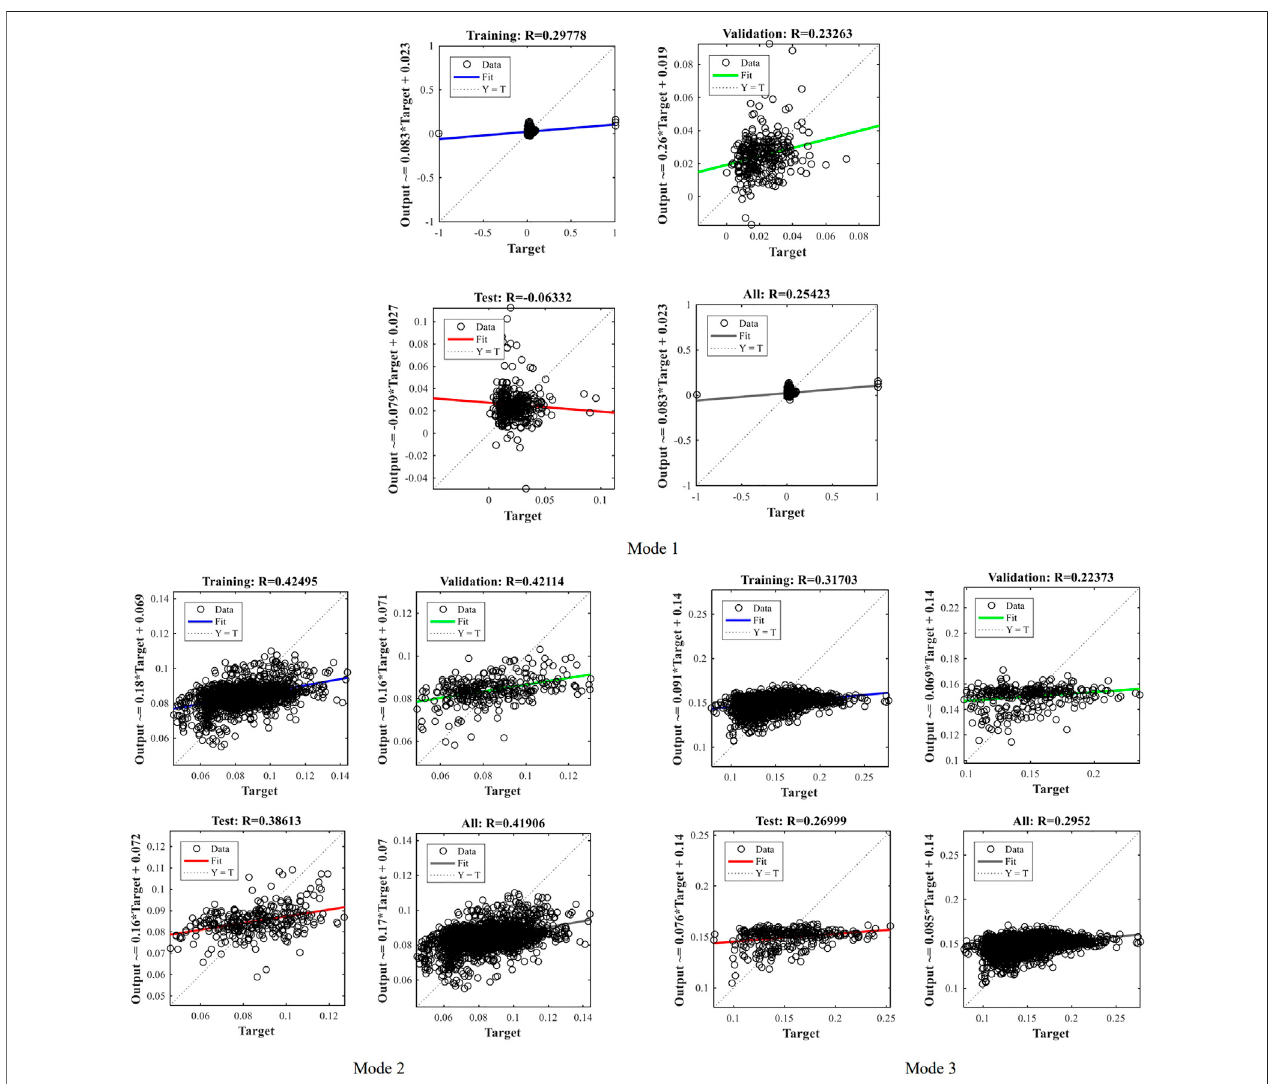
FIGURE 4 | R-M-ANN model training regression chart for mode